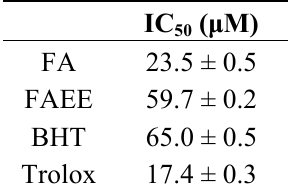
Table 1. DPPH Scavenging Activity.